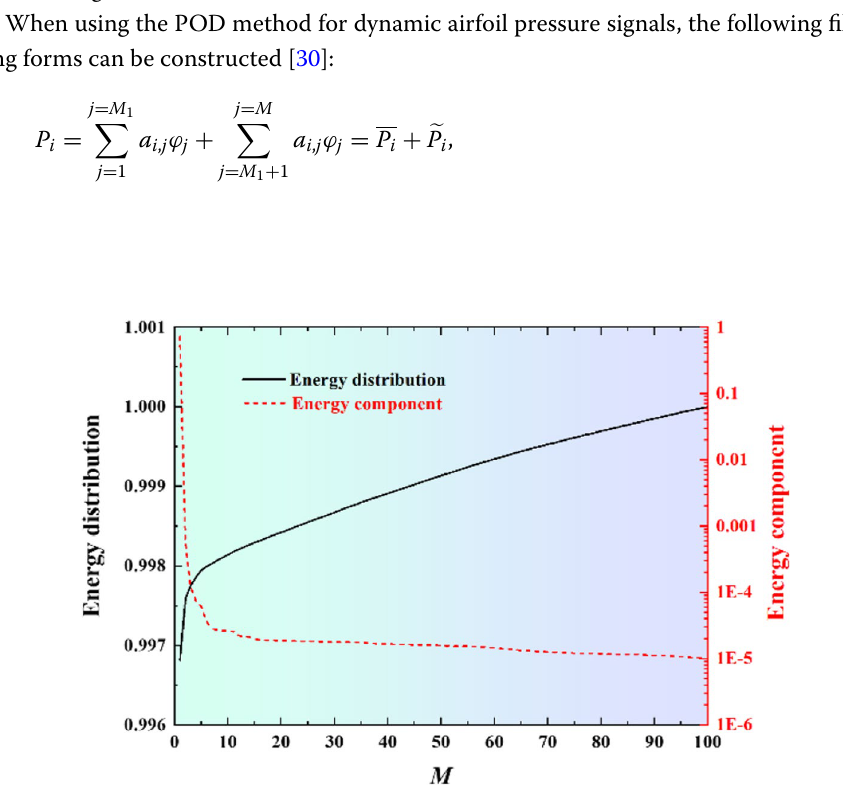
Fig. 8 Energy distribution of POD